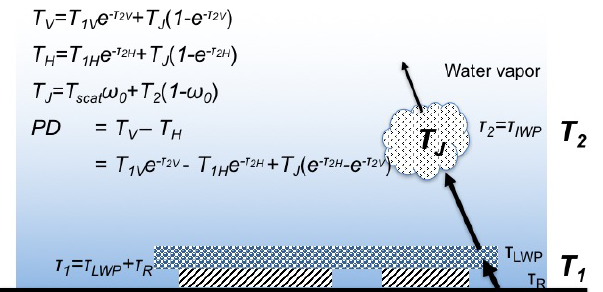
Figure 6. Schematic two-layer model with a liquid/rain/surface layer at T 1 and an ice cloud layer at T 2 to explain the observed bell curve in the PD–TB V relationship. See the text for more details and a definition of the